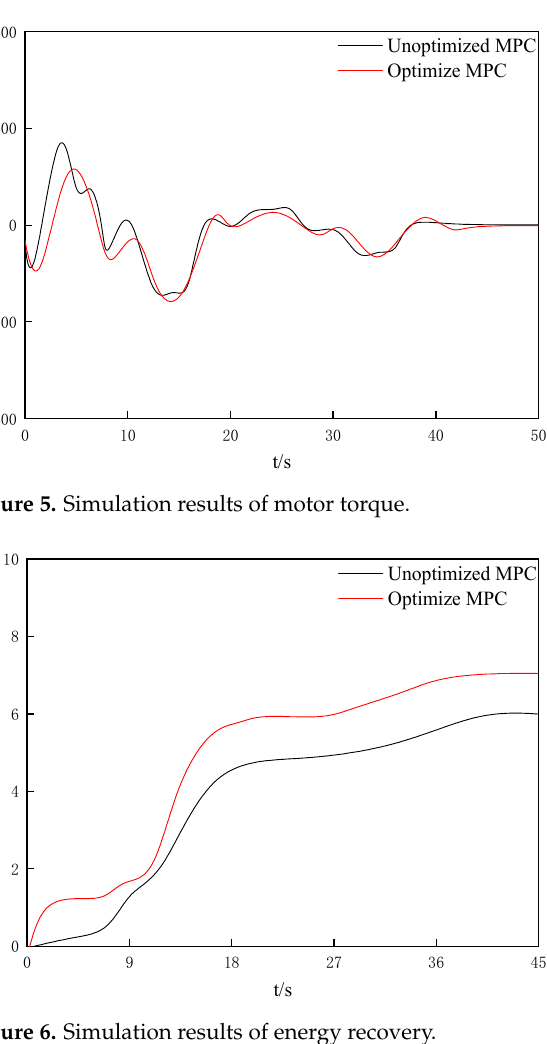
Figure 4. Acceleration simulation results.